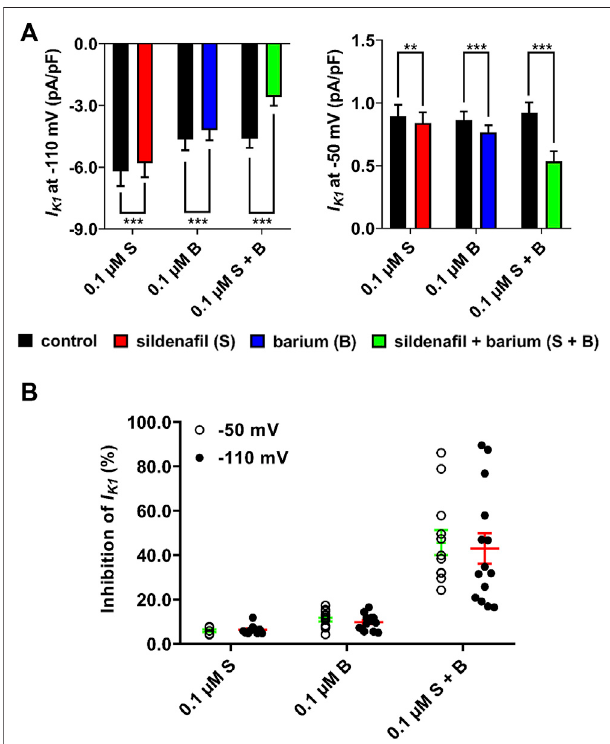
FIGURE 3 | Synergistic inhibitory effect of sildena fi l and Ba 2+ at a low concentration of 0.1 µM. (A) Changes of I K1 in the presence of sildena fi l and Ba 2+ , applied both separately and in combination; paired t -test, *, ** and *** — statistically signi fi cant difference at p < 0.05, 0.01 and 0.001, respectively. (B) Massive inhibition of I K1 appeared after combined application of both sildena fi l and Ba 2+ . The inhibition was signi fi cantly more potent than a simple sum of separate effects of sildena fi l and Ba 2+ . The effect was not signi fi cantly different between voltages.